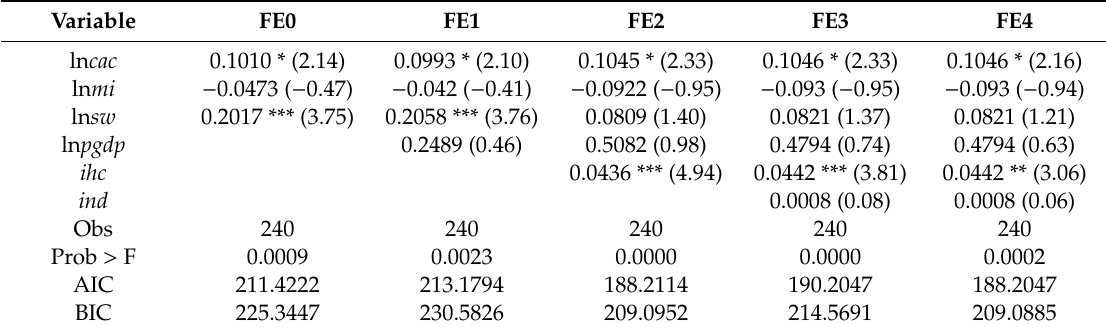
Table 3. The results of fixed e ff ect regression model of environmental policy instruments on green technology